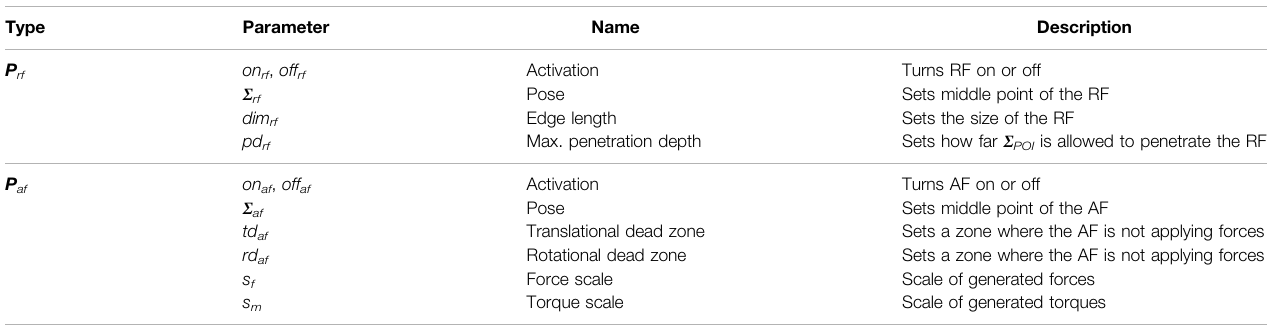
TABLE 1 | This table displays the corresponding parameters of RF and